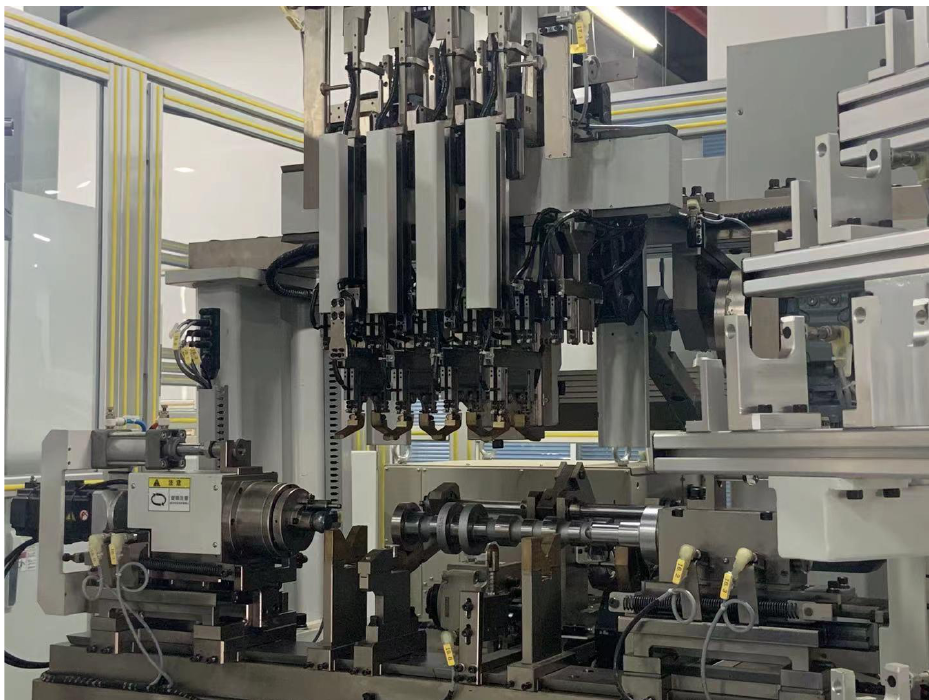
Figure 11. Crankshaft measuring machine.